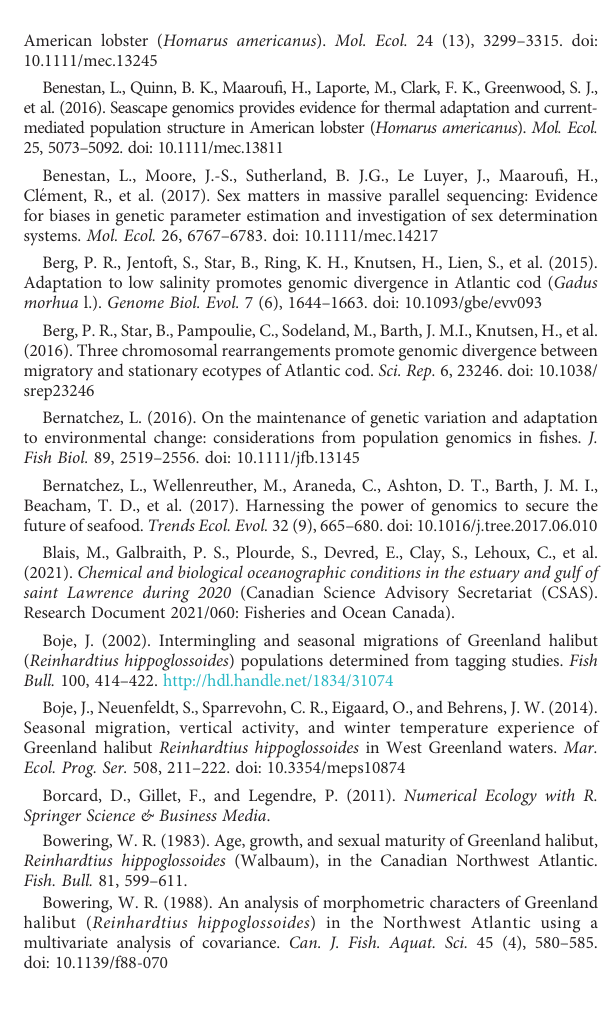
SUPPLEMENTARY TABLE 2 Results of the Redundancy of